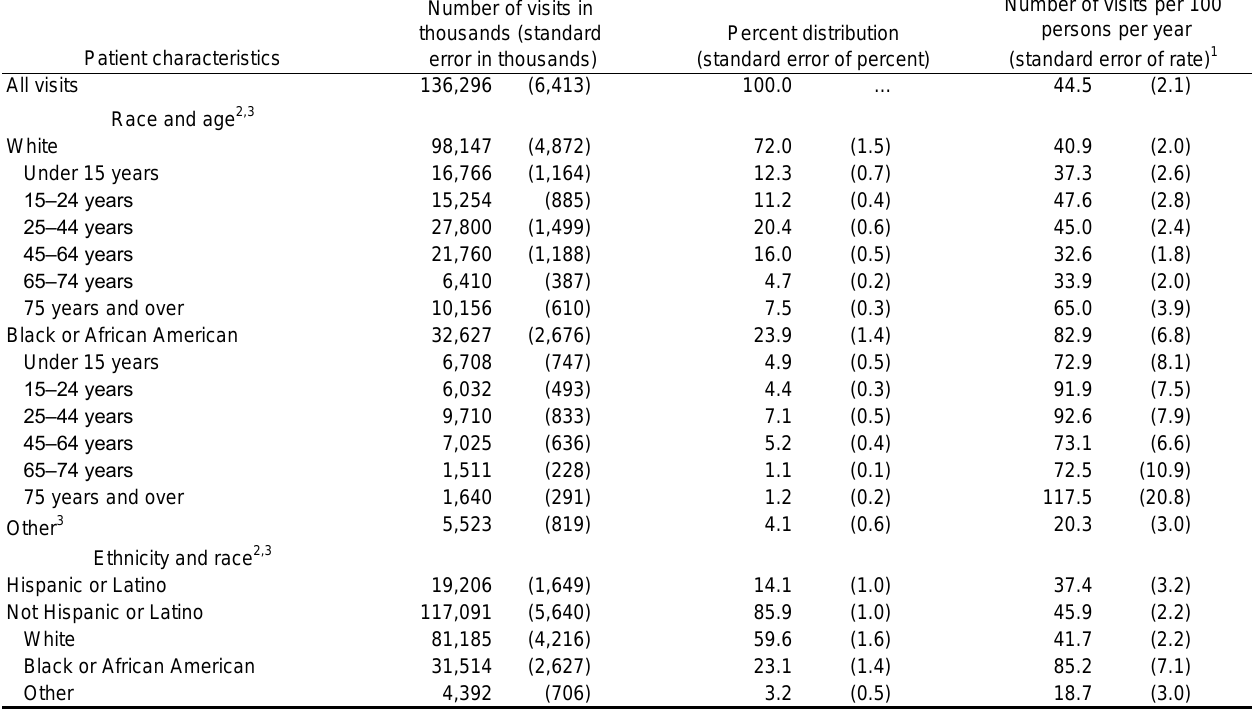
Table 3. Emergency department visits by patient race and age, and ethnicity: United States, 2011 Number of visits